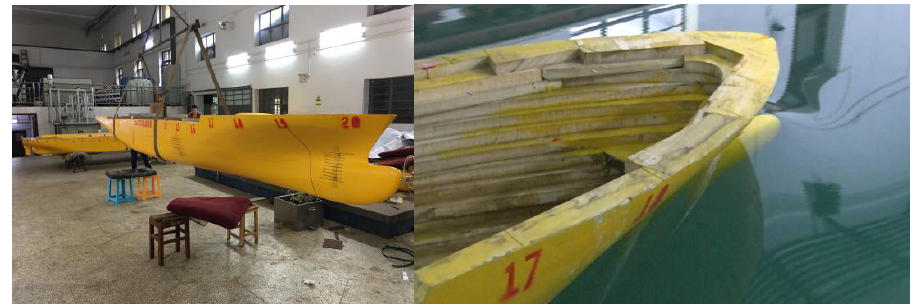
Figure 2. The test model of the 13500TEU container ship.